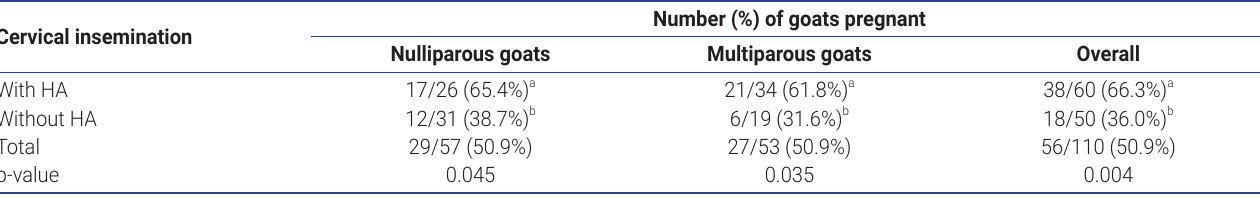
Table 1. The pregnancy rate after cervical insemination using frozen-thawed semen with or without topical application of Hyaluronan (HA) in nulliparous and multiparous goats Number (%) of goats pregnant Cervical insemination Nulliparous